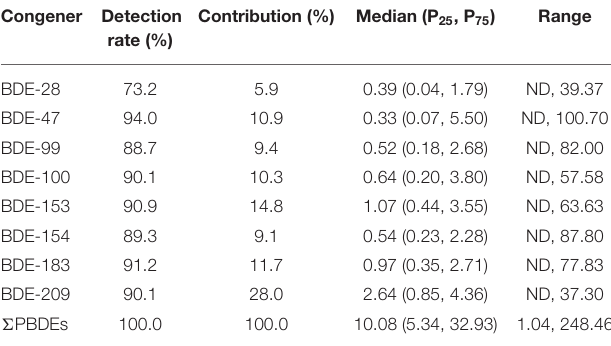
TABLE 2 | Concentrations of PBDEs (ng/g lipid wight) in human placenta ( n =